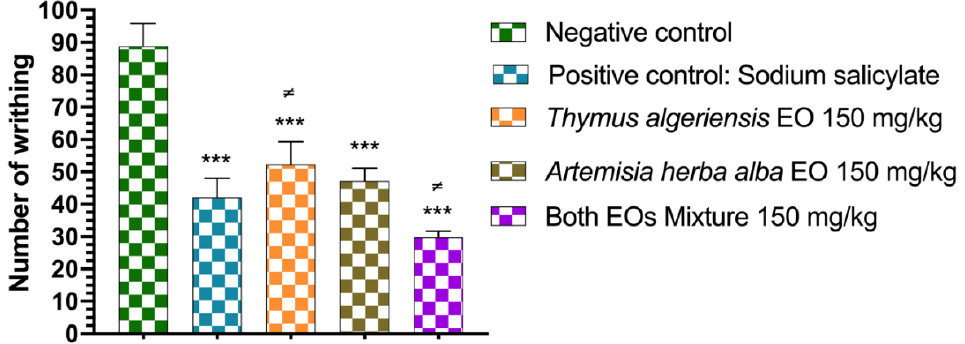
Figure 4. Analgesic activity of the studied essential oils and their mixture. The values are expressed as the mean ± standard error of the mean ( n = 5), ***: p < 0.001 compared to negative control ≠ p < 0.05 compared to the positive control.